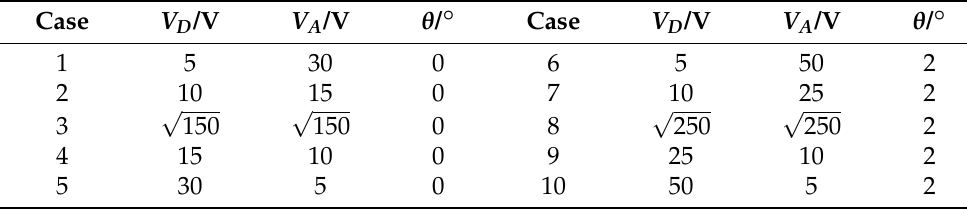
Table 2. The parameters corresponding to different cases in Figure